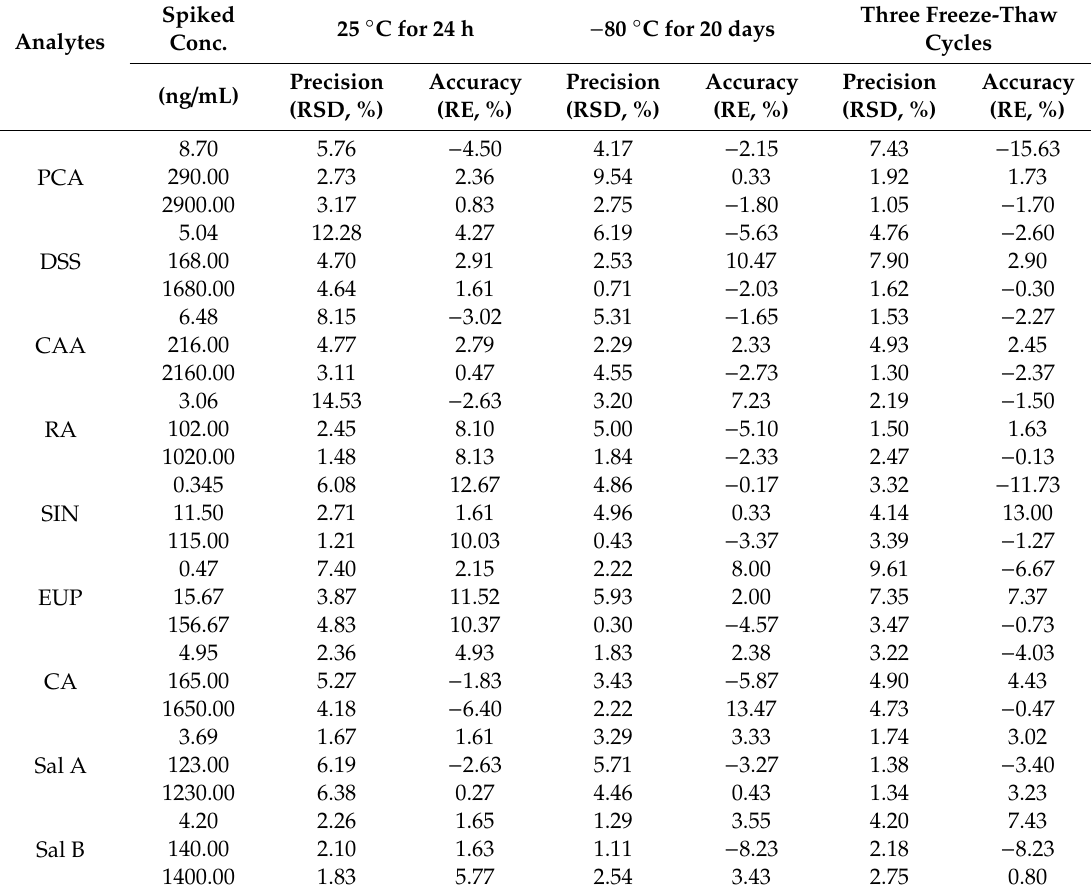
Table 4. Stability of the nine analytes in rat plasma samples ( n = 3).